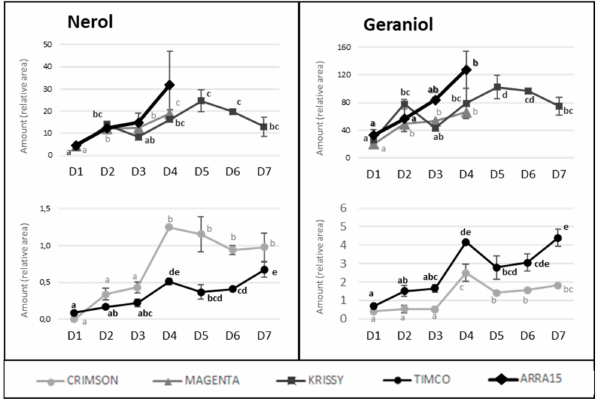
Figure 5. Progression of nerol and geraniol amounts along maturity and storage in all the table grapes. Di ff erent superscript letter indicates statistically significant di ff erences among the sampling times D1–D7 ( p < 0.05). Sampling along harvest: D1 , veraison; D2 , 12 DAV (days after veraison); D3 , 26 DAV; D4 , 37 DAV. Sampling along storage: D5 , 54 DOS (days of storage); D6 , 75 DOS; D7 , 108